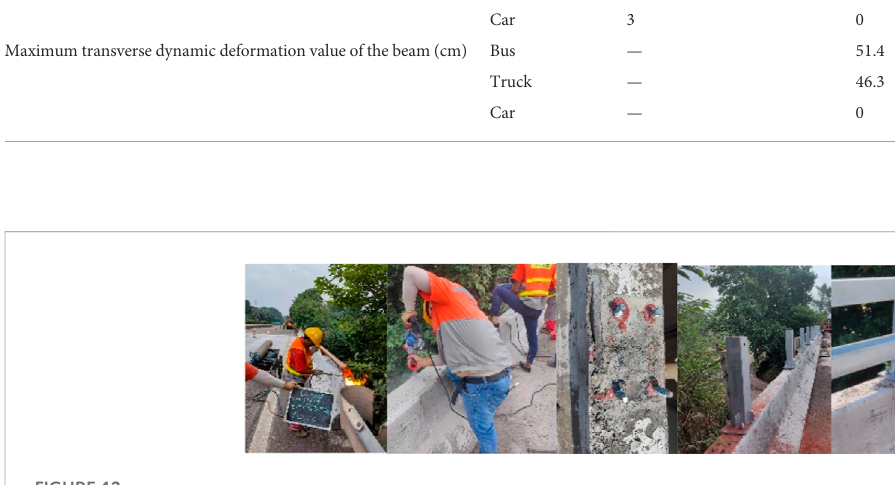
FIGURE 12 Photographs of site construction.